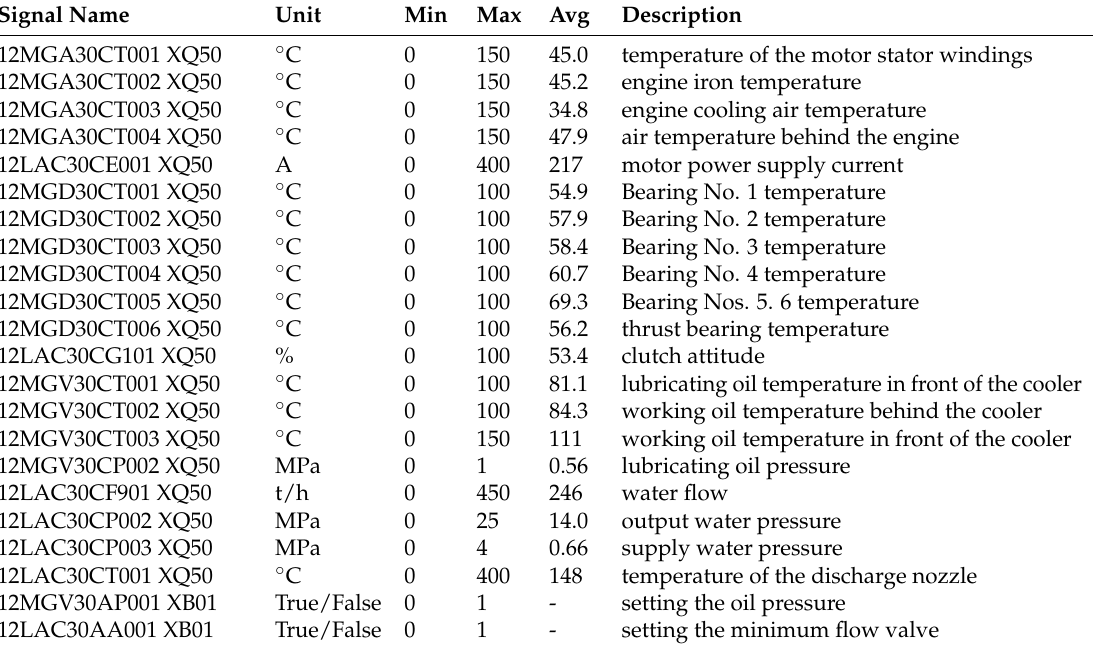
Figure 3. Difference between the real and estimated value of the water flow behind the pump. Table 1. Description of the input data collected by the sensors located on the pump